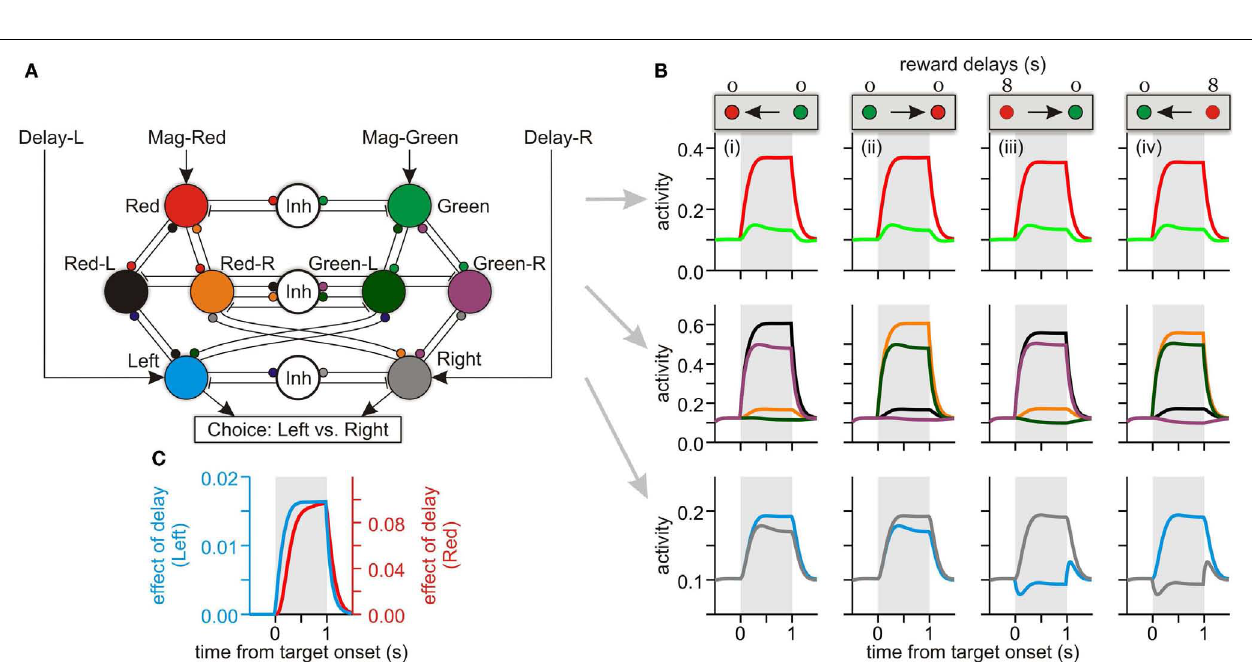
FIGURE 6 |Time course of neural activity related to different types of temporally discounted values (DVs) and the animal’s choice in DLPFC (A), CD (B), andVS (C). Coefficient of partial determination (CPD) was computed using a 200-ms sliding window separately for the activity related to